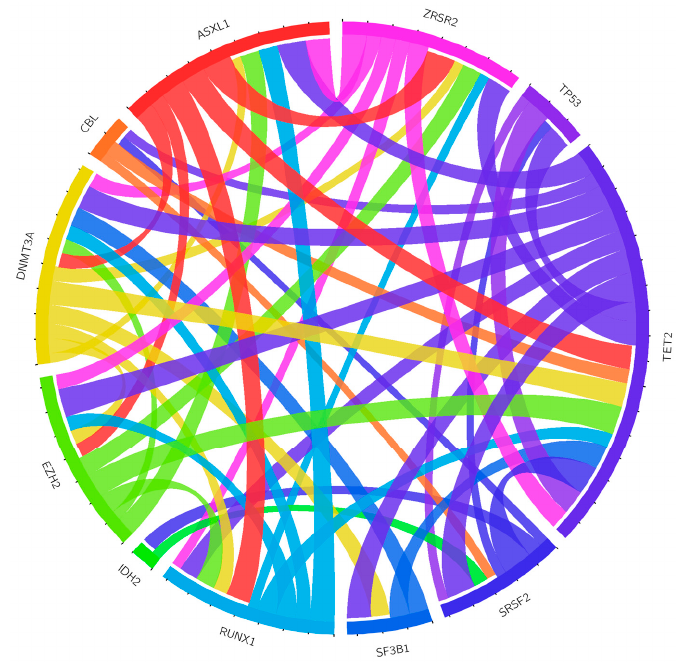
(https://www.cbioportal.org/visualize, accessed on: 10 April 2021).